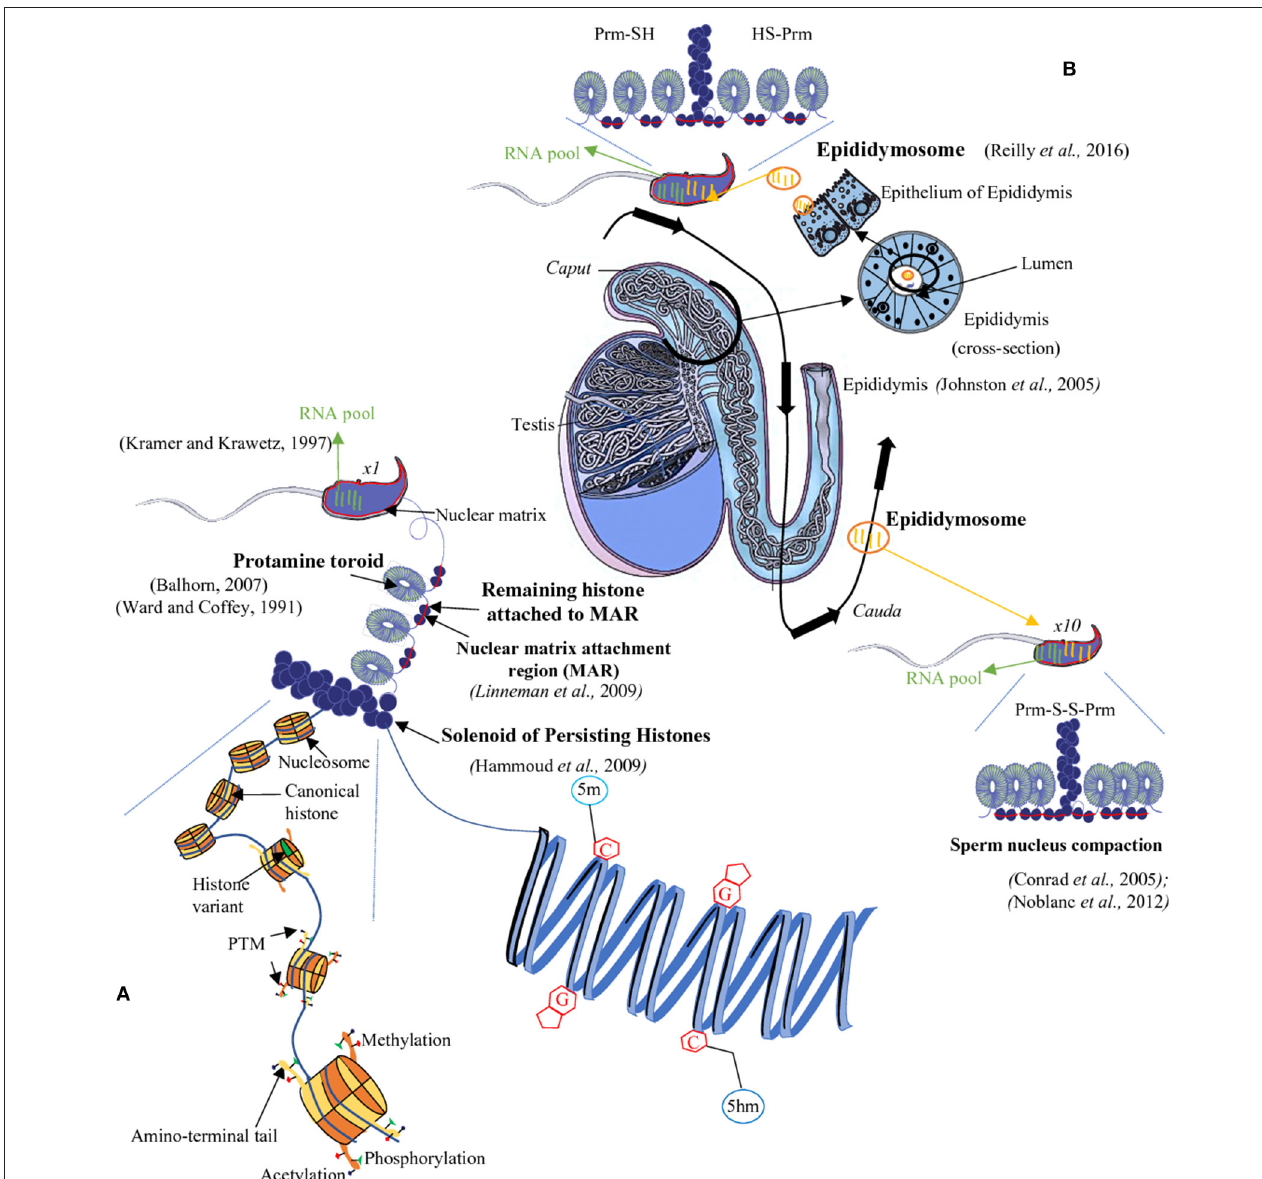
FIGURE 1 | The sperm epigenome. During spermatogenesis, most histones are replaced by protamines (PRM). However, few histones remain in chromosomal domains called ≪ solenoid ≫ as well as in the short DNA segments connecting two adjacent toroids which are also attached to the sperm nuclear matrix (Matrix Attachment Regions = MAR, red bar). The sperm DNA is thus mainly packaged into toroids (protamine rich regions) and, for a minor proportion, into solenoids (histone rich regions) overall allowing a great condensation of the chromatin (A) . This condensed state of the sperm nucleus is further enhanced during epididymal maturation via intra- and inter-protamine disulfide bonds (B) . The sperm nucleus also harbors epigenetic marks at various levels: for example, on the sperm DNA there are complex methylation profiles with regions rich in 5-methylcytosine (5 mC) as well as in 5-hydroxymethylcytosine (5hmC). At the level of the sperm chromatin, persisting histones are concerned by a vast array of post-translational modifications (PTM; A ). Finally, a third epigenetic information is associated with the sperm cell it is represented by a complex pool of RNA (mRNA and several classes of non-coding RNA). This RNA-mediated epigenetic information is acquired both during spermatogenesis and the post-testicular maturation processes (i.e., during epididymal transit; black arrow) with non-coding RNA being transferred from the epididymal epithelium toward sperm cell via lipid-rich exosomes named, epididymosomes (B) . C, cytosine; G, guanine; SH, thiol group; S-S, disulfide bridge.